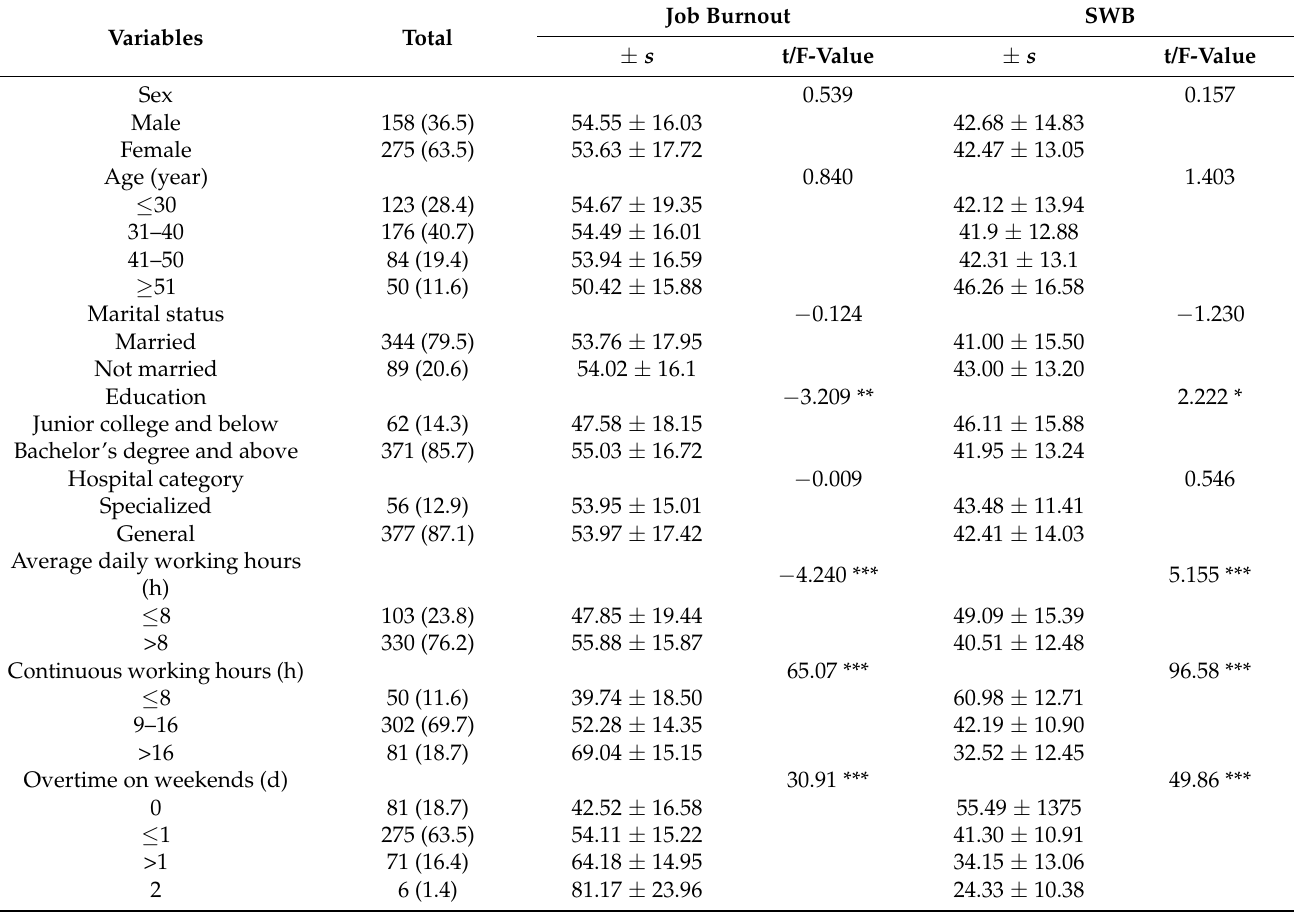
Table 2. The distributions of job burnout and SWB among hospital administrators (N =